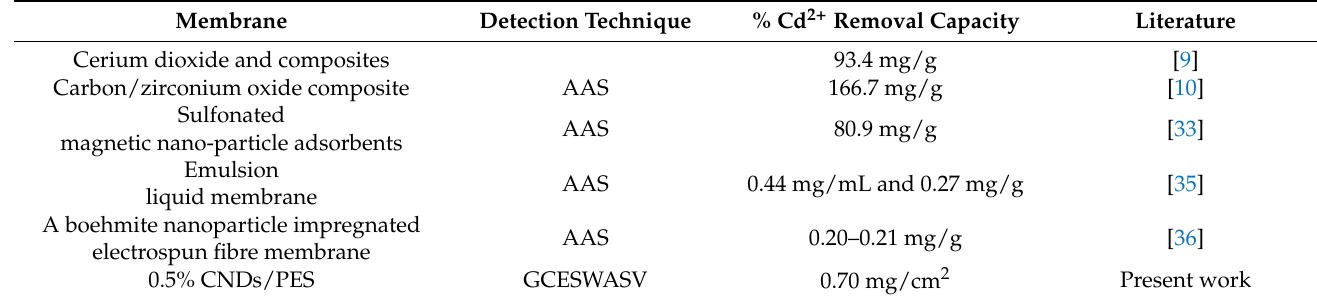
Table 4. Comparison of differently modified PES membranes for Cd 2+ removal from standard samples.